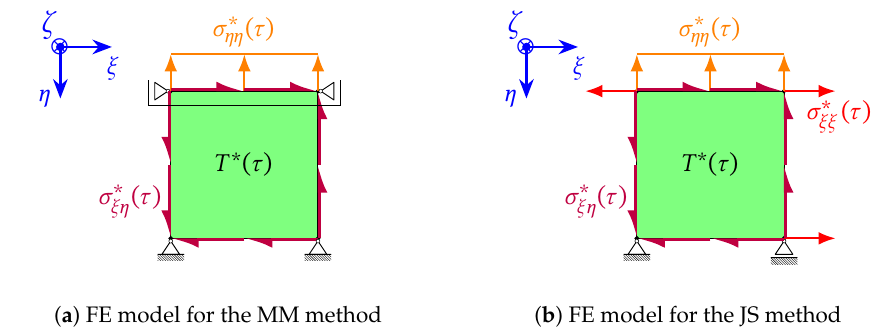
Figure 5. FE models used to validate our implementation of the approximation schemes’ transient step. τ denotes the (pseudo-)time during the transient analysis. The bar connecting the bearings at the top two nodes in subfigure ( a ) represents a multi-point constraint that enforces equal displacement ( τ ) are prescribed by surface traction definitions in Abaqus while in the ξ -direction. σ ∗ ηη ( τ ) and σ ∗ ξη ( τ ) for the JS three nodal forces are defined to enforce σ ∗ ξξ